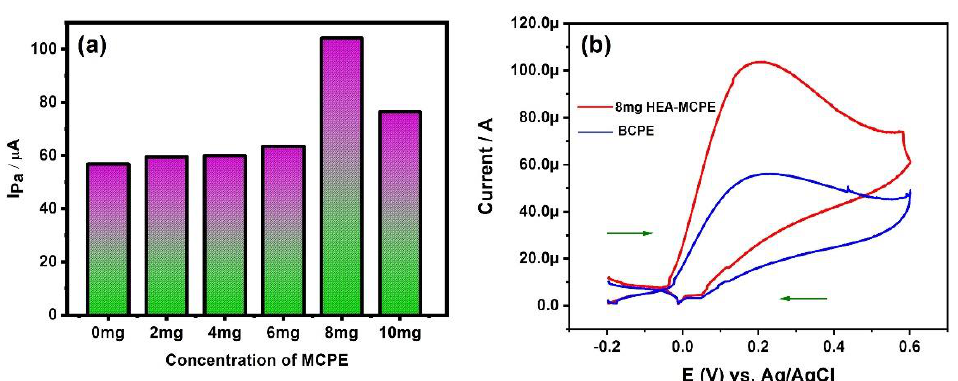
Figure 7. ( a ) Graphical representation of anodic peak current of HEA-MCPE at different concentrations (0, 2, 4, 6, 8, and 10 mg). ( b ) Cyclic voltammogram (CV) of 2 mM AA at BCPE and 8 mg HEA-MCPE.